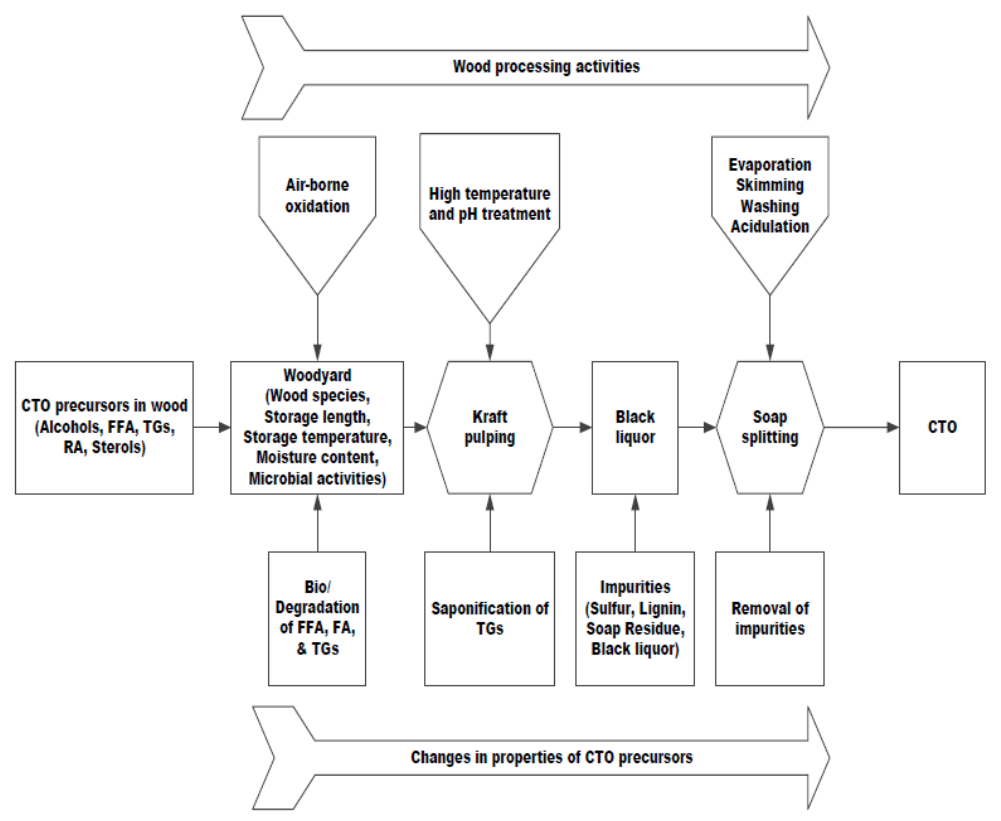
Figure 1. Modification of crude tall oil (CTO) precursors from wood handling to CTO recovery. Triglycerides (TGs), Resin acids (RAs), Free fatty acid (FFA), Fatty acid (FA).